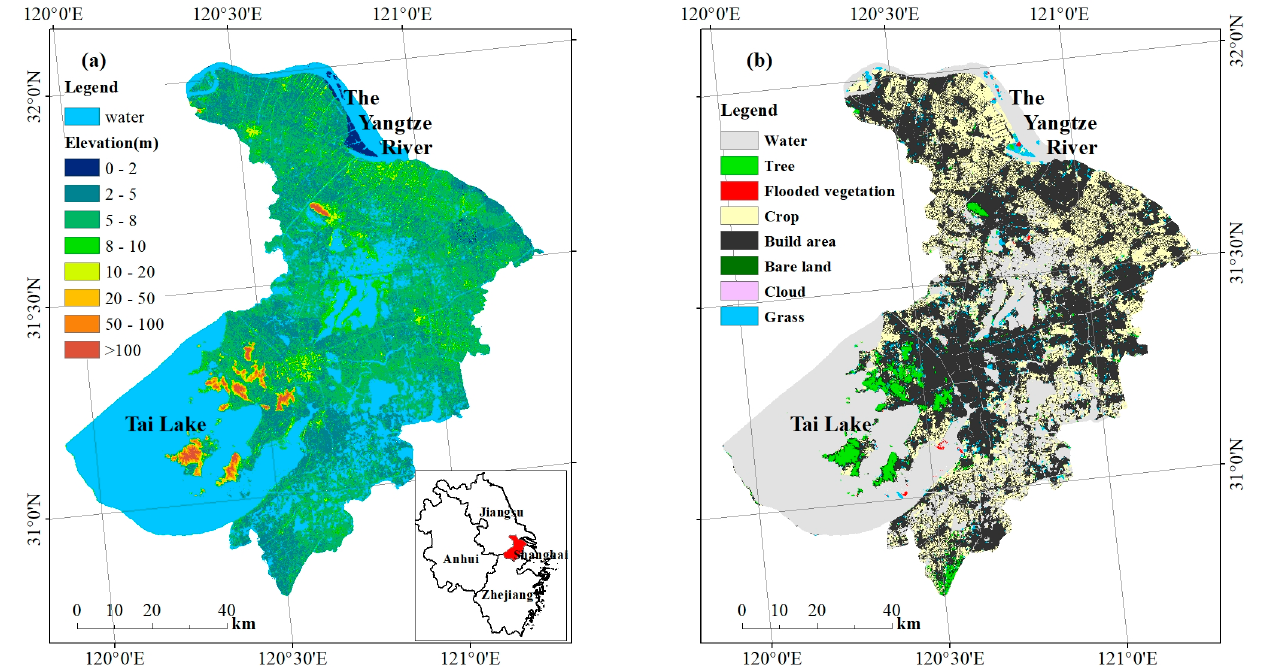
Figure 1. The geographic location ( a ) and land cover ( b ) derived from Sentinel-2 by ESRI of Suzhou in Jiangsu province in China.